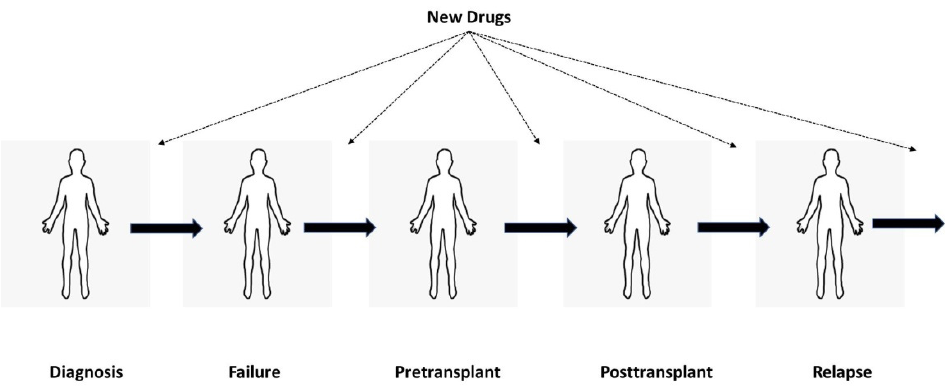
Figure 1. The possible place of new CLL drugs in a typical transplant scheme.